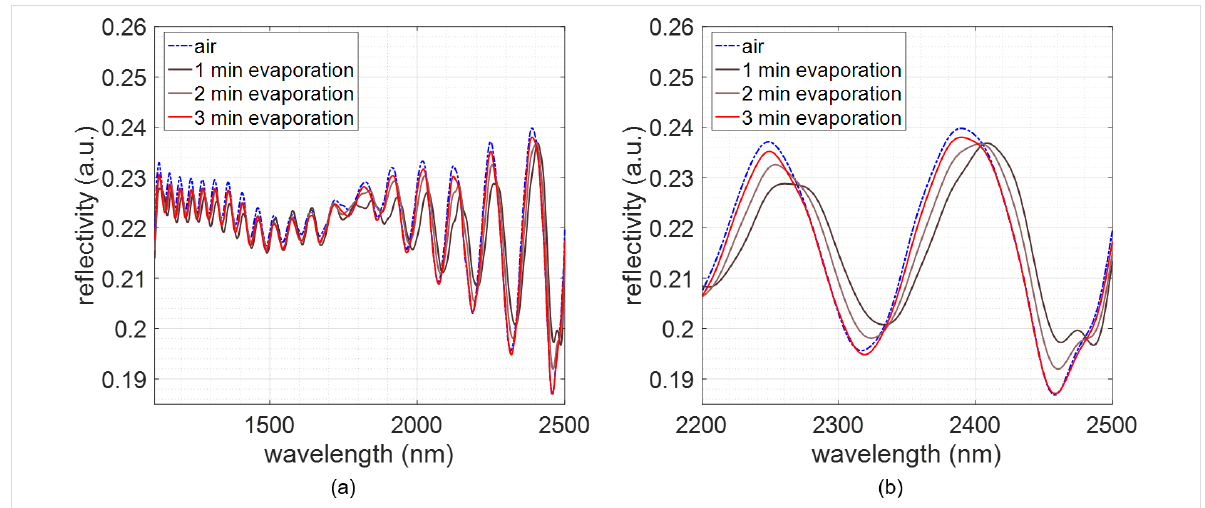
Figure 3: Evolution of the reflectivity spectrum of the PCTE membrane when placing pure ethanol on it. (a) For the whole characterization range (be- tween 1110 and 2500 nm). (b) Detail of the spectral region between 2200 and 2500 nm.